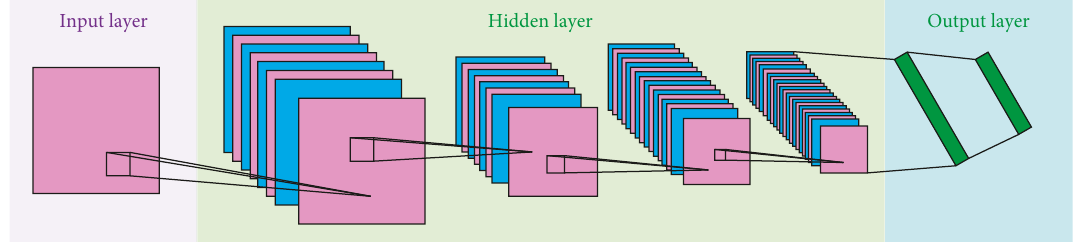
Figure 2: Convolutional neural